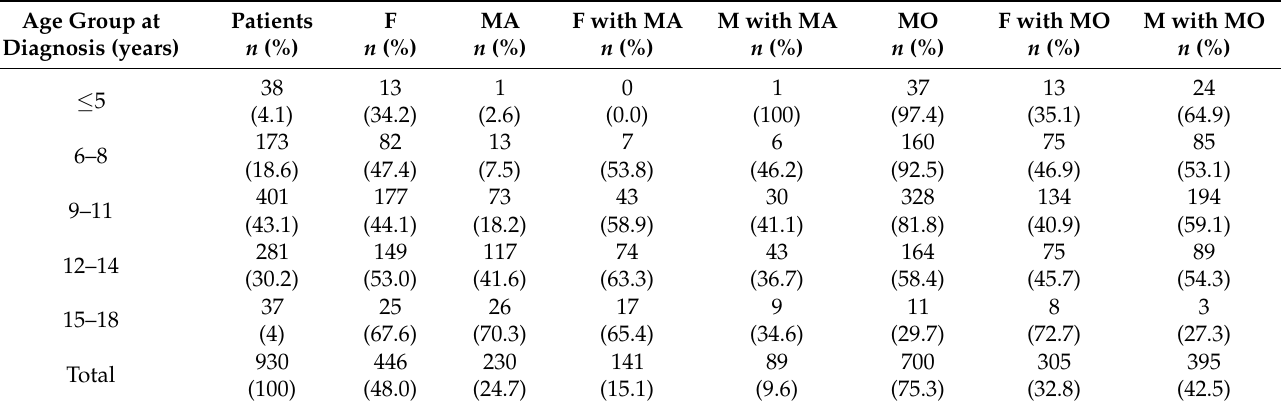
Table 2. Characteristics of the study population after stratification into five age groups ( ≤ 5